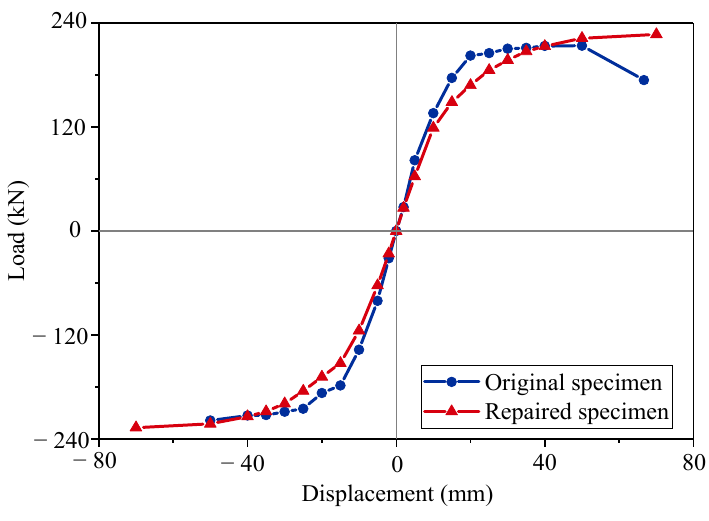
Figure 11. Skeleton curves.